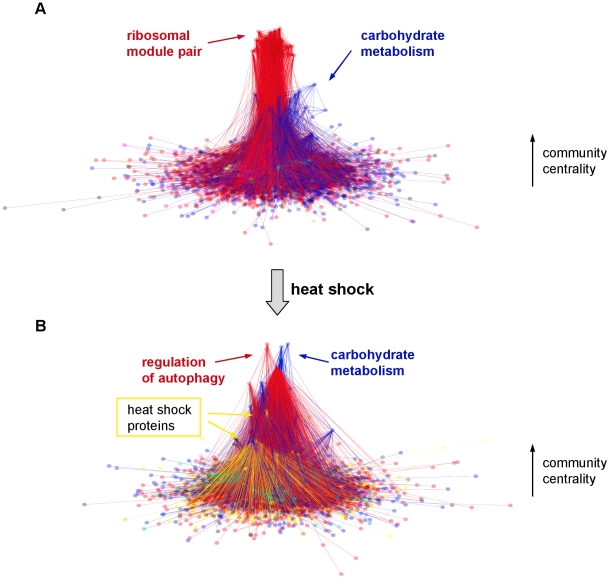
Changes of the modular structure of the yeast protein-protein interaction network after heat shock.Unstressed (panel A) and heat shocked (15 min heat shock at 37°C, panel B) yeast BioGRID protein-protein interaction networks were created as described in the Materials and Methods section. The 2D representation of yeast interactomes was visualized using the Fruchterman-Reingold algorithm. The vertical positions reflect the community centrality values of the nodes calculated by the NodeLand influence function method [8], and were plotted using a fourth root scale. Modular assignment of yeast proteins was performed by the ProportionalHill module membership assignment method [8]. Nodes were colored according to the module they maximally belong to. The functions of modules were assigned by the functions of the core modular proteins as described in the Materials and Methods section. The functional labels and the arrows had the same colors as their respective modules. Panel A. Modular structure of the unstressed yeast interactome. Two overlapping major modules had a large centrality: a ribosomal module-pair and a module representing carbohydrate metabolism. Panel B. Modular structure of the interactome of heat shocked yeast cells. The centrality of ribosomal modules decreased, which is in agreement with the diminished translation in heat shock. Besides modules of carbohydrate metabolism, upon heat shock several, formerly minor, heat shock-induced modules gained centrality, and became visible on the 3D plot. Modules related to autophagy, a key factor of the stress-response, also increased their centrality.